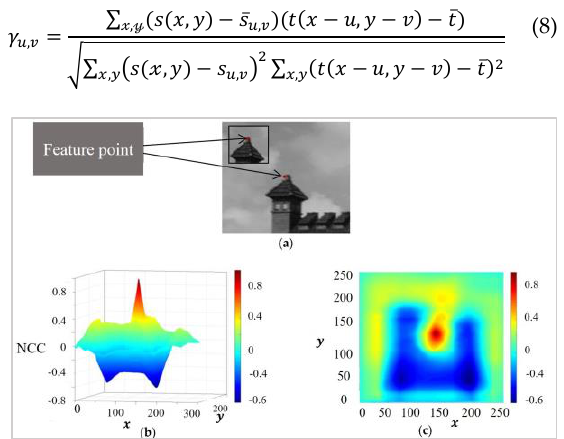
Figure 5. (a) the template window around the feature 𝓺 𝒋 slides over the search images (a larger image around the estimated feature 𝓹 𝒋𝓕 ). (b) The NCC score is maximum at the concurrence point. (c) a planar view of the NCC